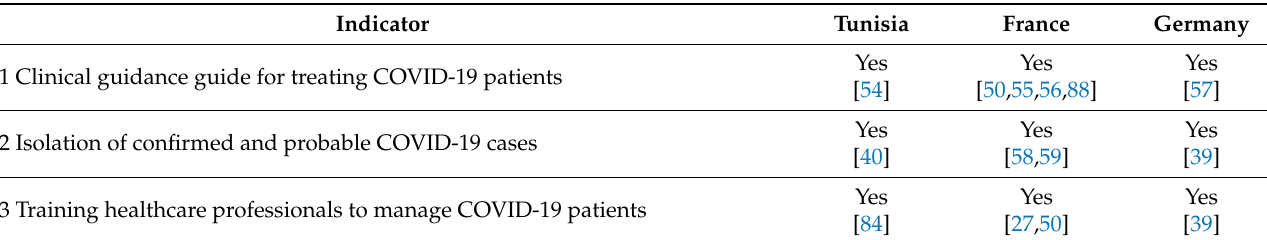
Table 9. Pillar 7: Case management.